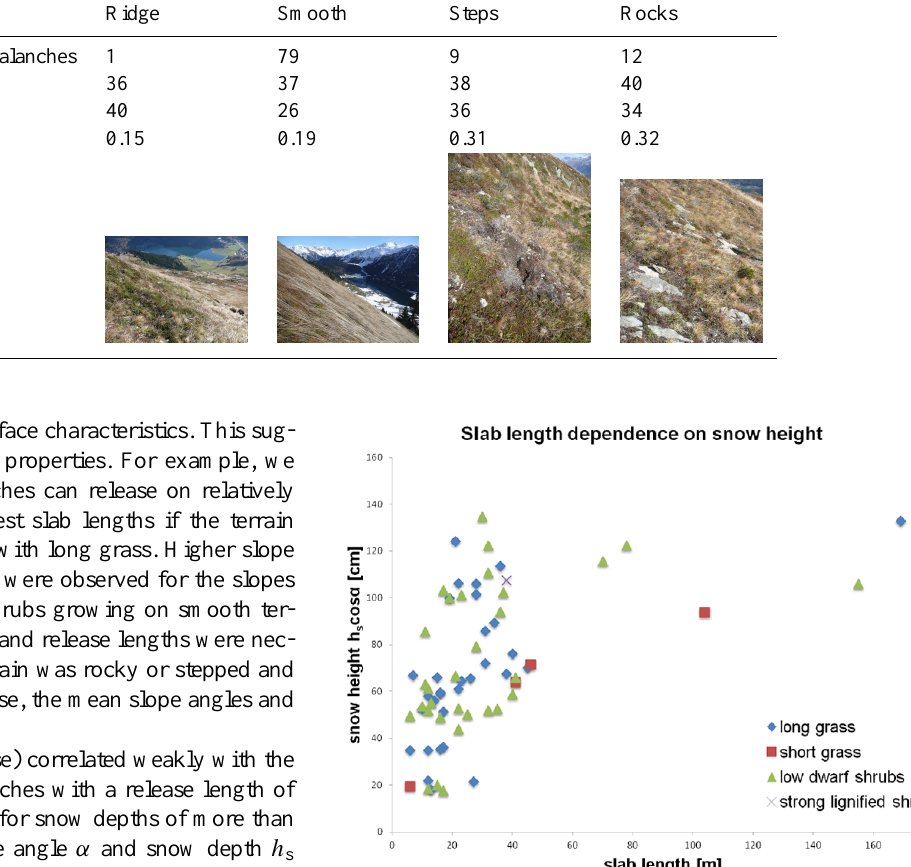
Table 2. The observed terrain on the Dorfberg. Mean slope angle α , slab length l g , terrain height h t and a photo of a typical example case are added. Note the high number of smooth terrain cases. Terrain Ridge Smooth Steps Rocks